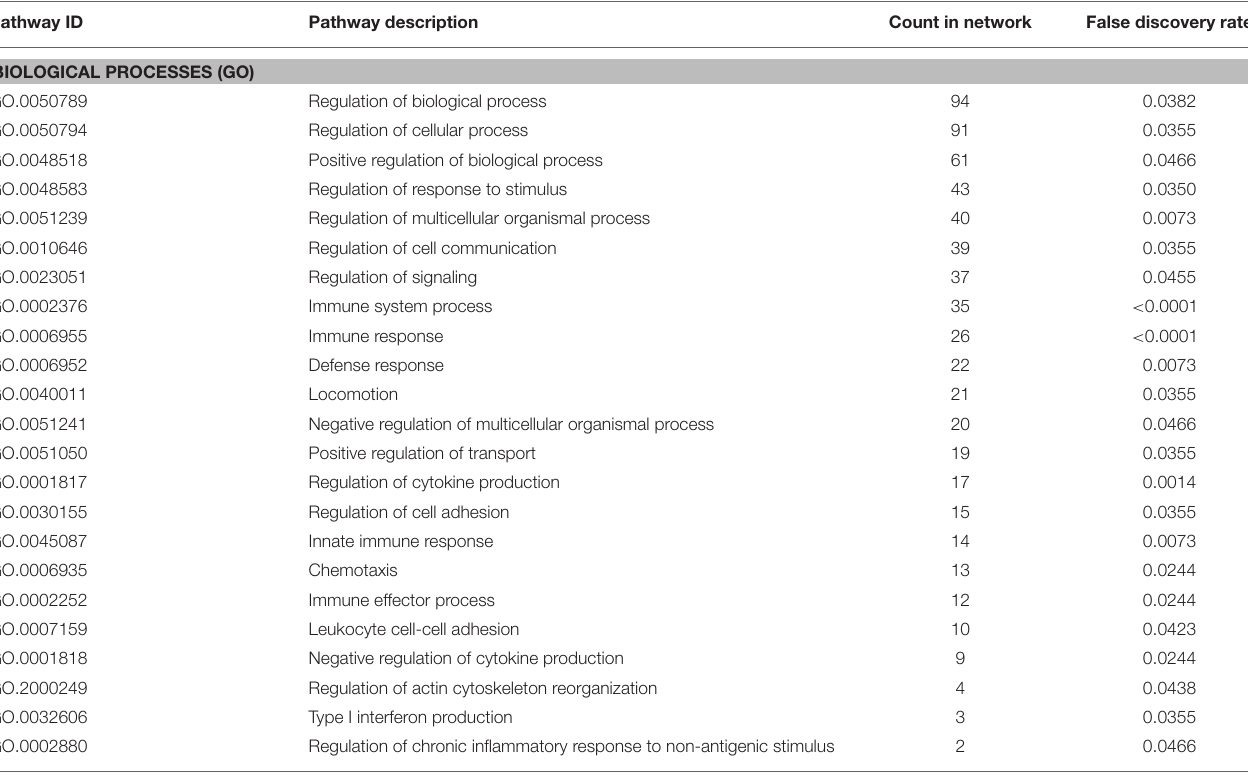
Whole genome was used as statistical